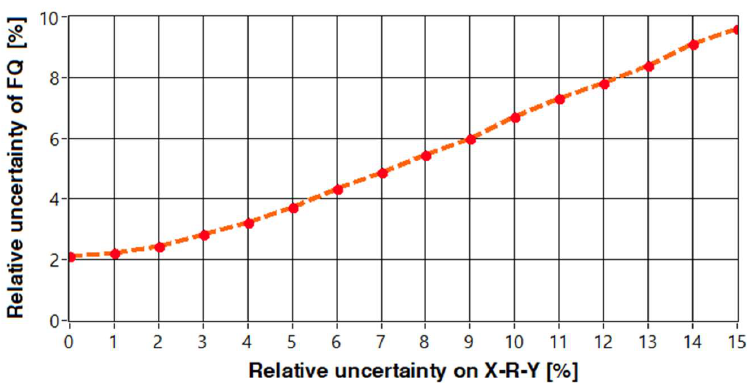
Figure 22. Relative uncertainty in the calculated reactive power flow of branch 1 of the “MTL3” line in dependence of the line parameters uncertainties.